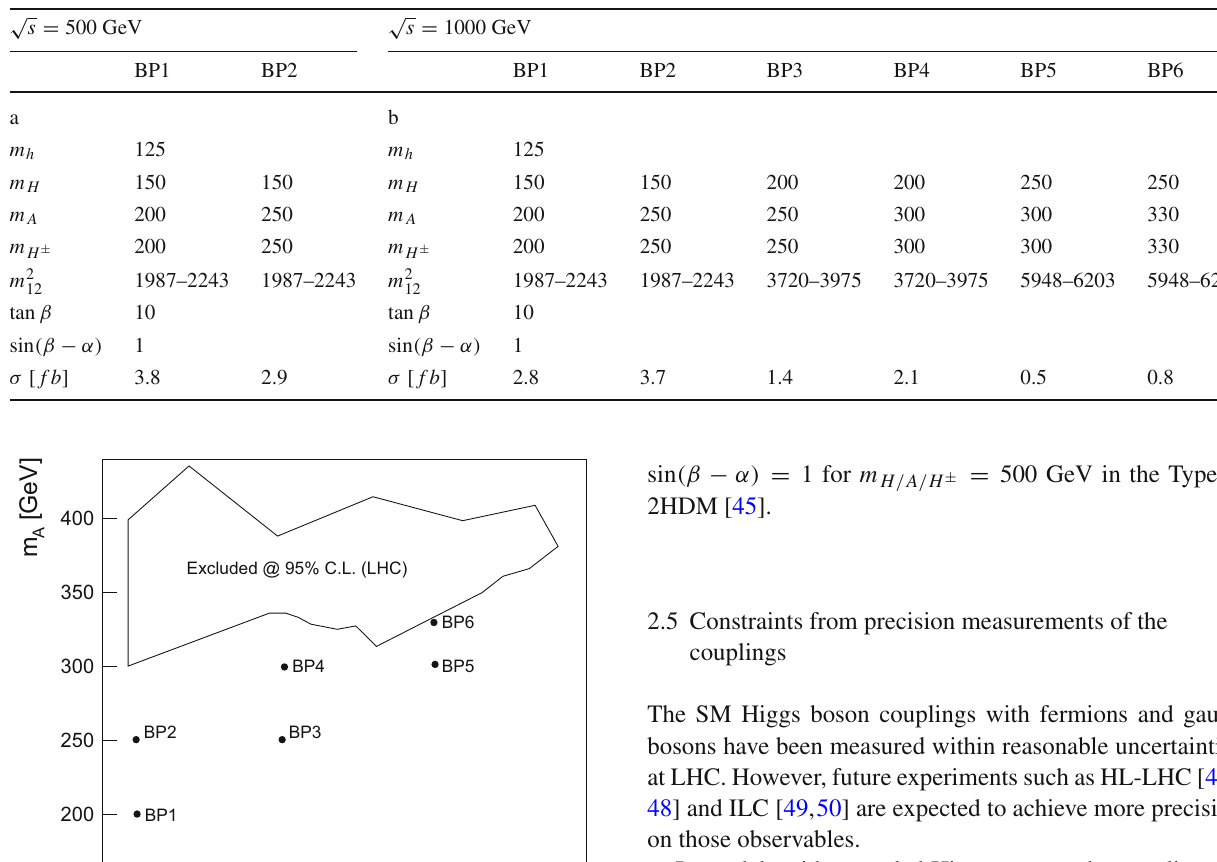
theoretical requirements. The signal cross section is also provided for each scenario range is the range satisfying 12